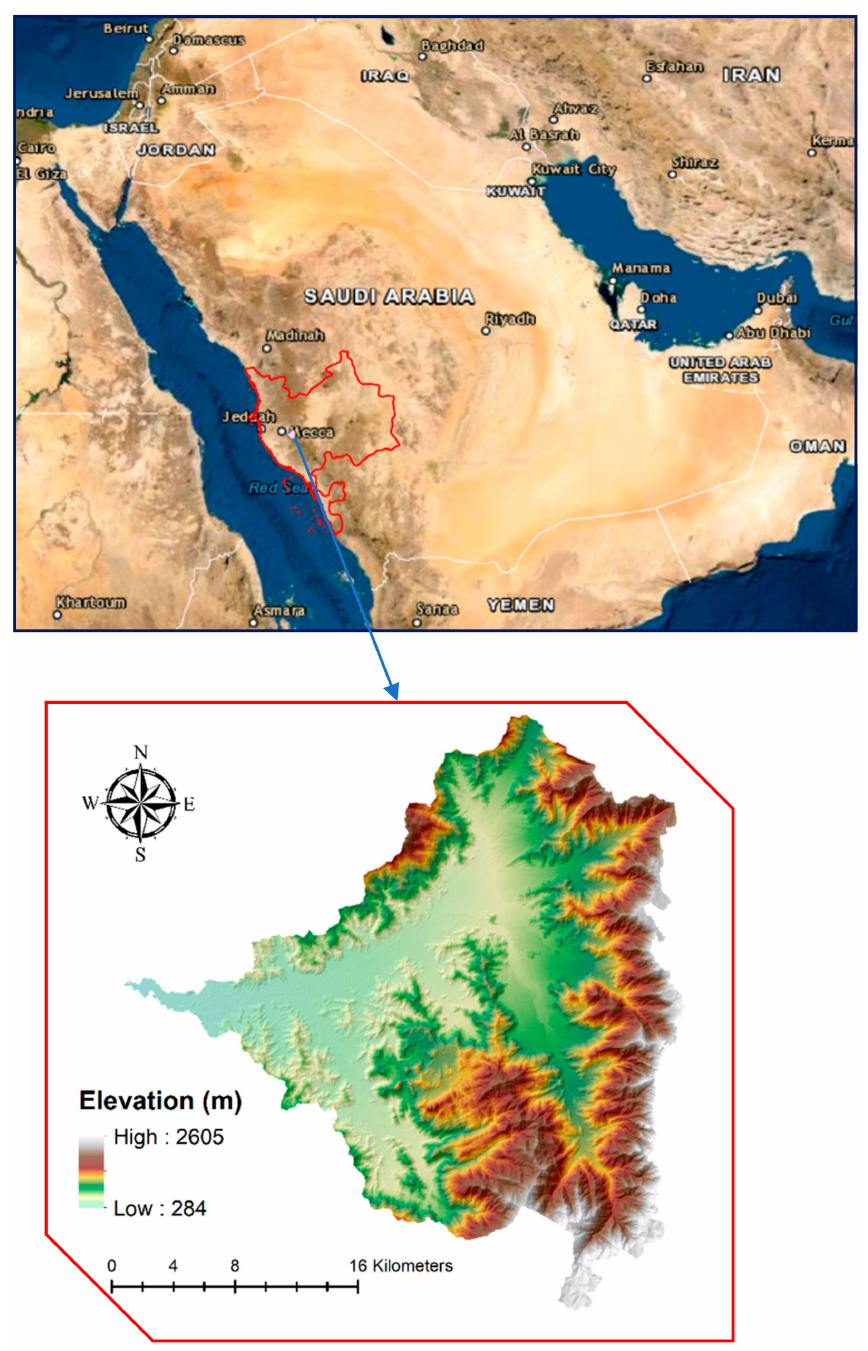
Figure 1. A map of the Wadi Nu’man watershed in Saudi